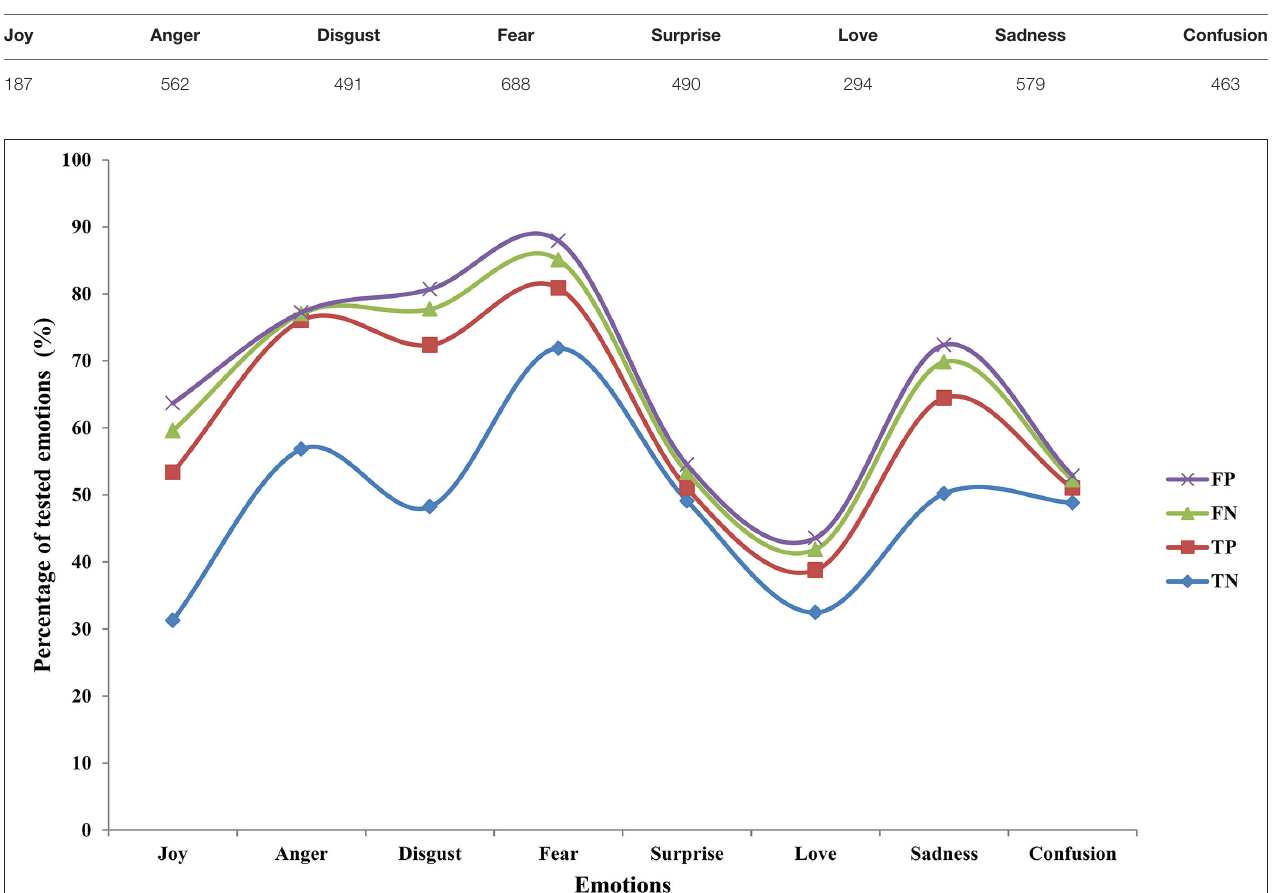
TABLE 4 | Total number of occurrences of the emotions tested for the training dataset.